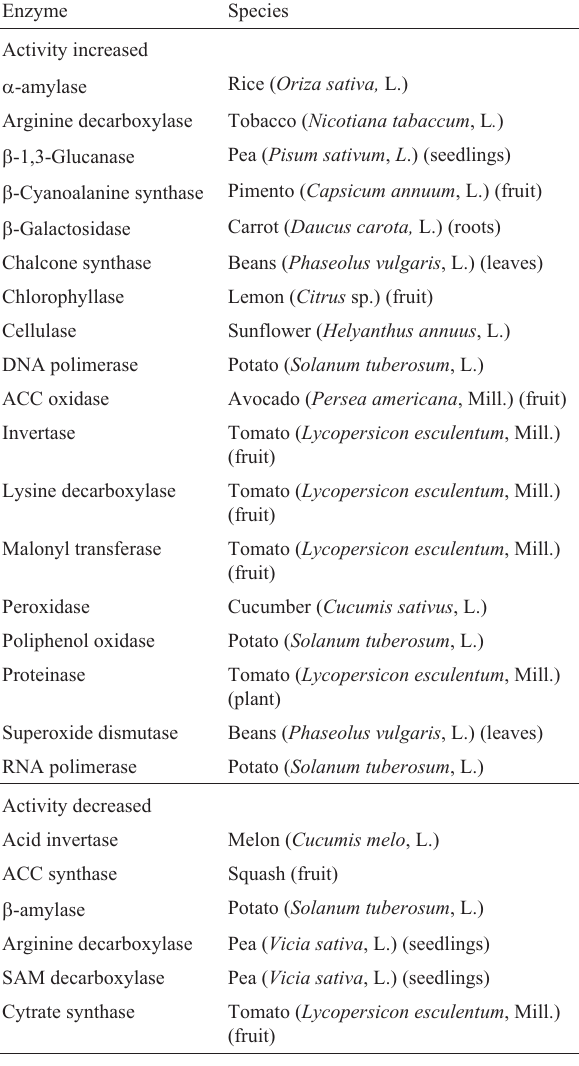
Table 1 - Effects of ethylene on plant development. (+) stimulus; (-) inhibition (from Ayub, 1995). Organ or